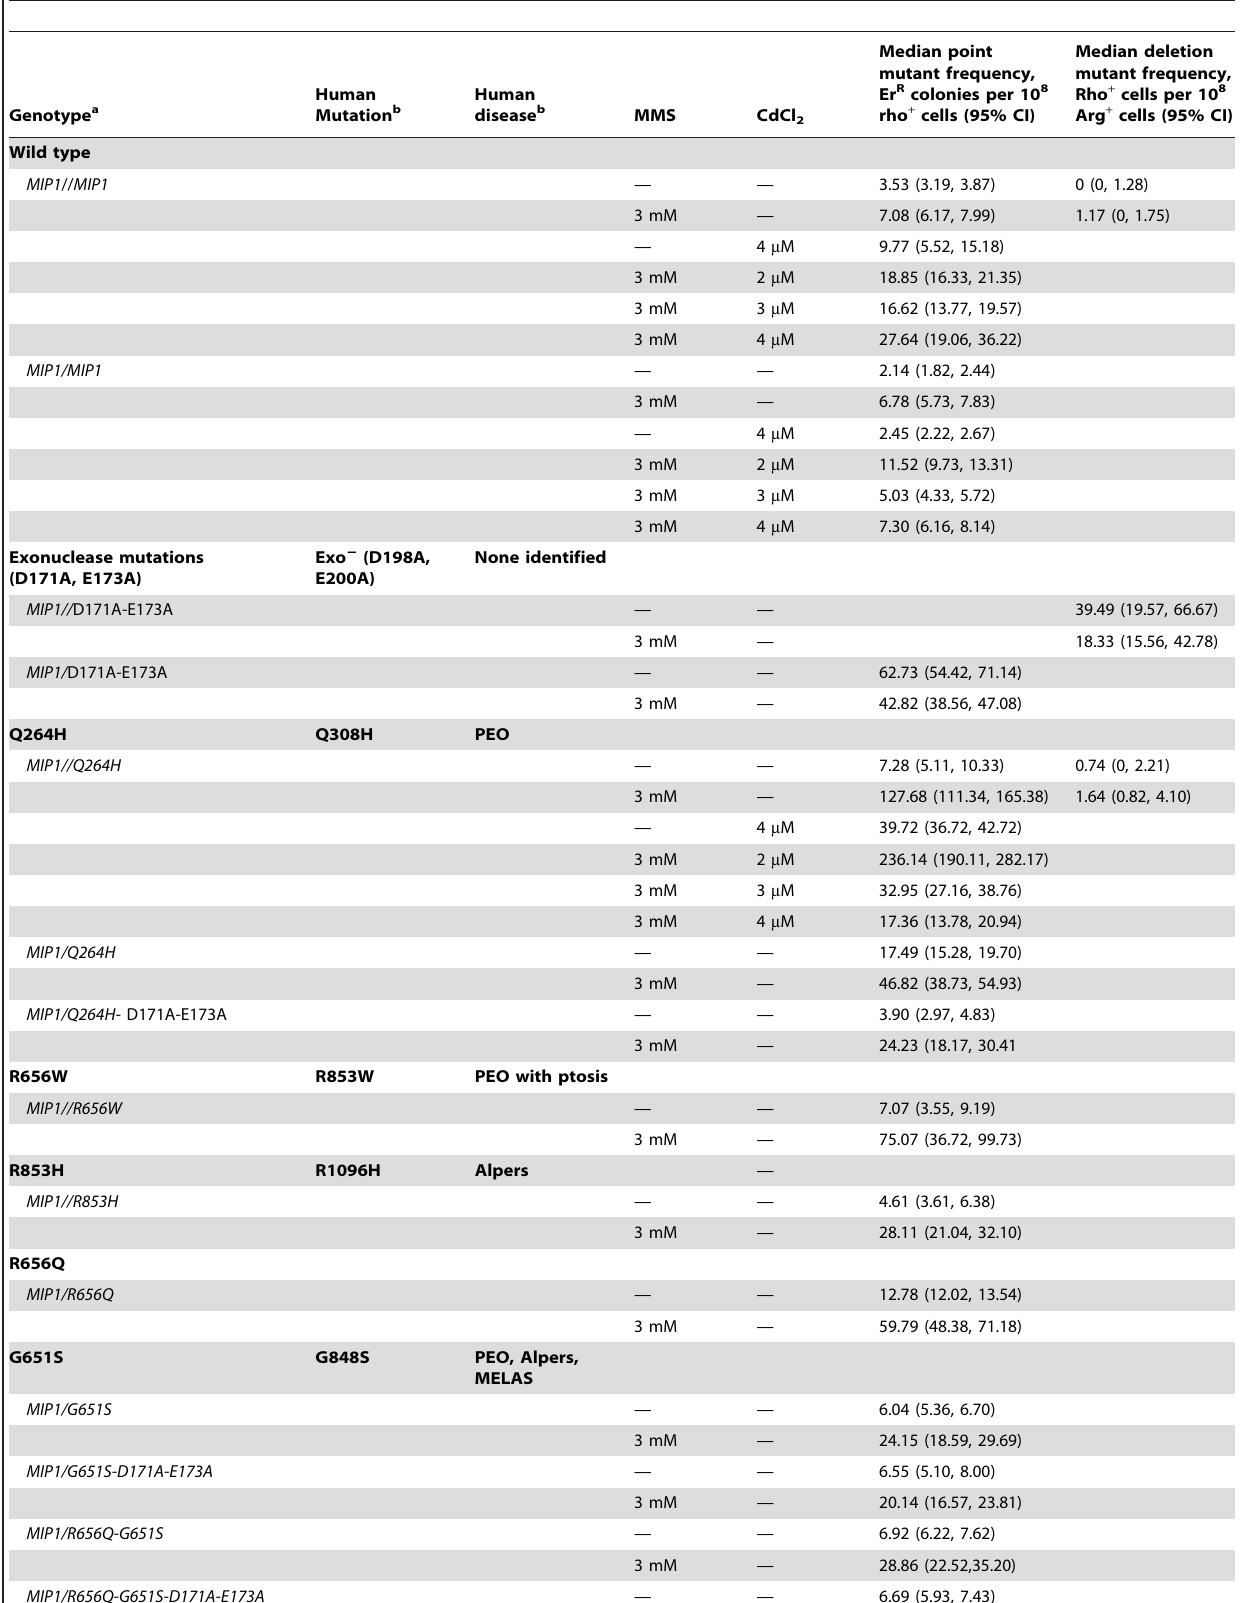
Table 1. List of Pol c mutations analyzed in this study and summary of